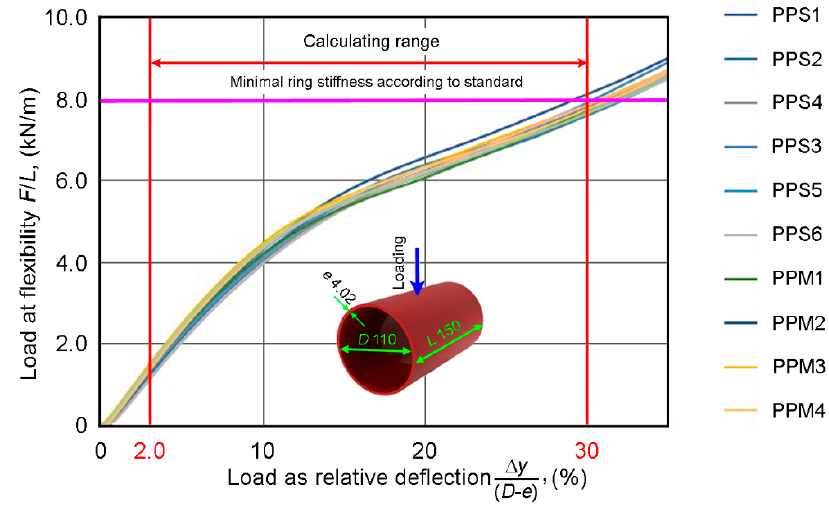
Figure 5. Ring stiffness and flexibility characteristics.